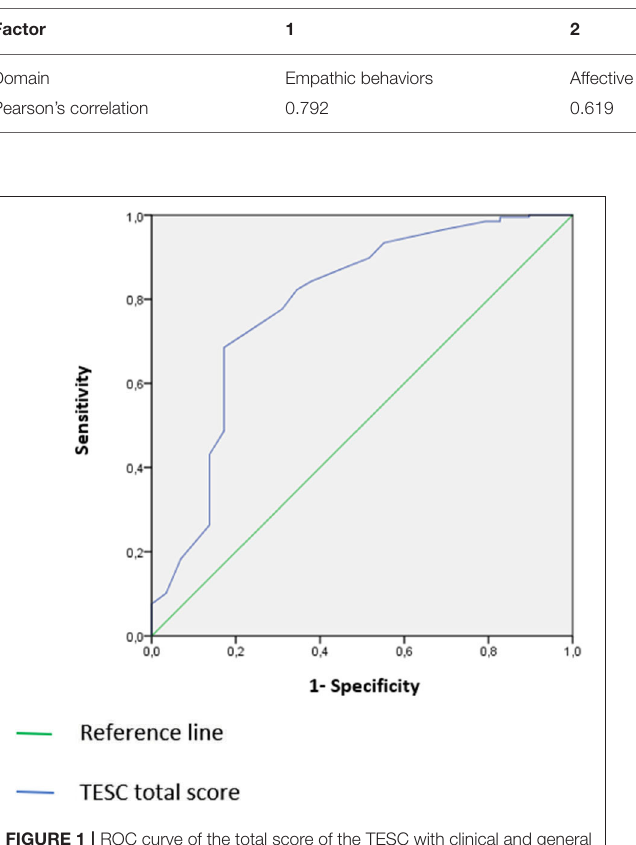
TABLE 2 | Subdomains and total score correlations.